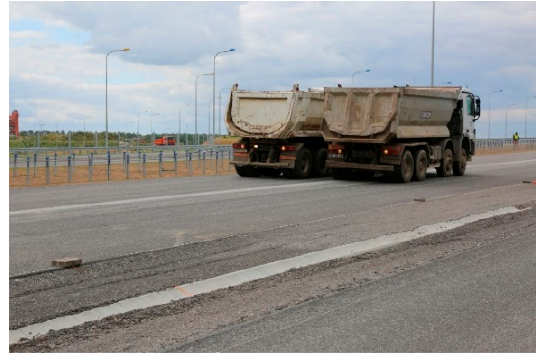
Figure 12. The trucks moving between M23 and M24 testing positions.